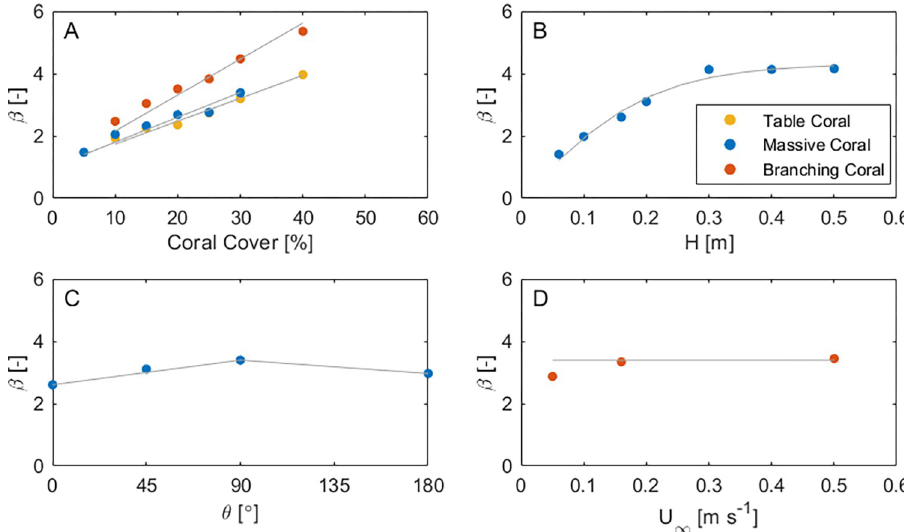
Fig 5. The extent of flow attenuation β for the three archetypal coral forms is impacted by: (A) the colony coral cover, (B) the water depth H , (C) the angle of the approaching flow to the morphology θ , and (D) the near-surface velocity U 1 . Where particular parameters were not varied, they took the default values in Table 1: coral cover of 20%, a depth of 0.16 m, a depth-averaged velocity of 0.16 m s -1 and θ = 0˚. The coral cover and water depth have the greatest influence on β . The grey lines demonstrate general trends, but do not represent a particular functional